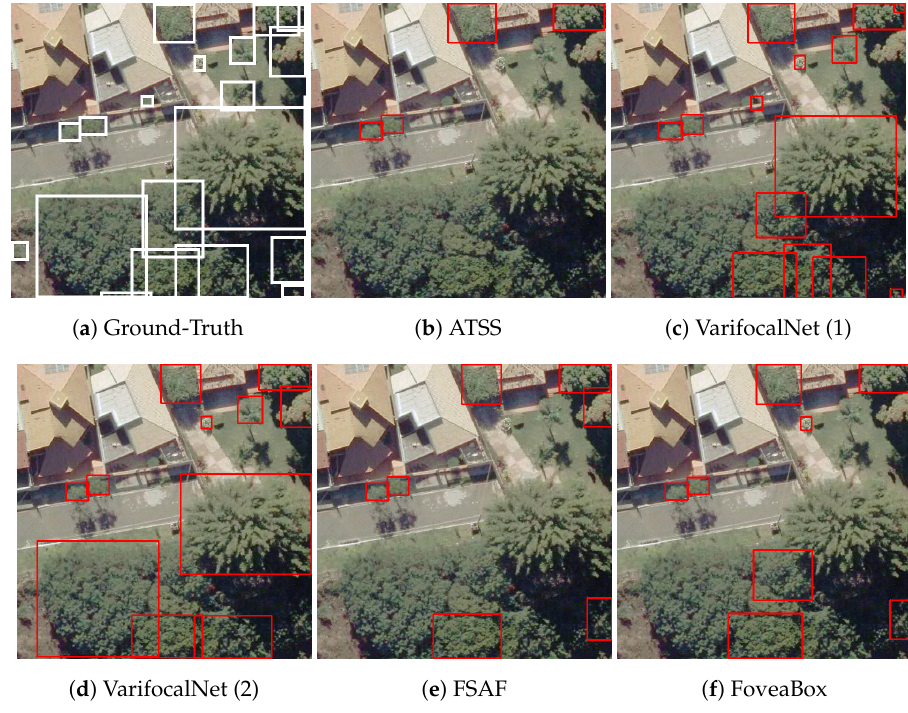
Figure 9. Examples of tree detection in areas with high density using the anchor-free methods.